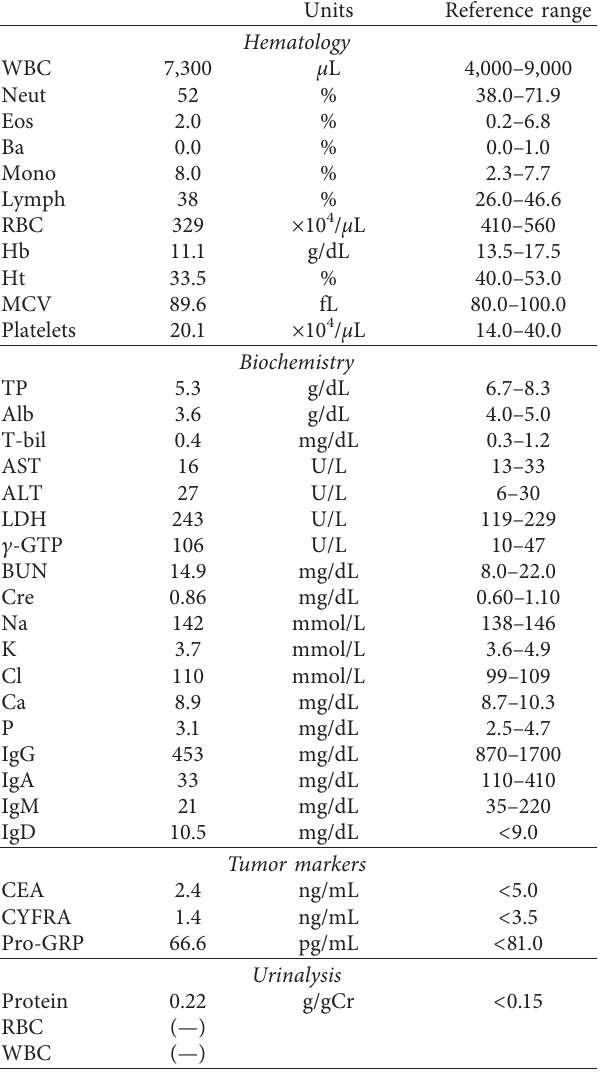
Table 1: Laboratory data at the time of diagnosis of gastric cancer and lung cancer.